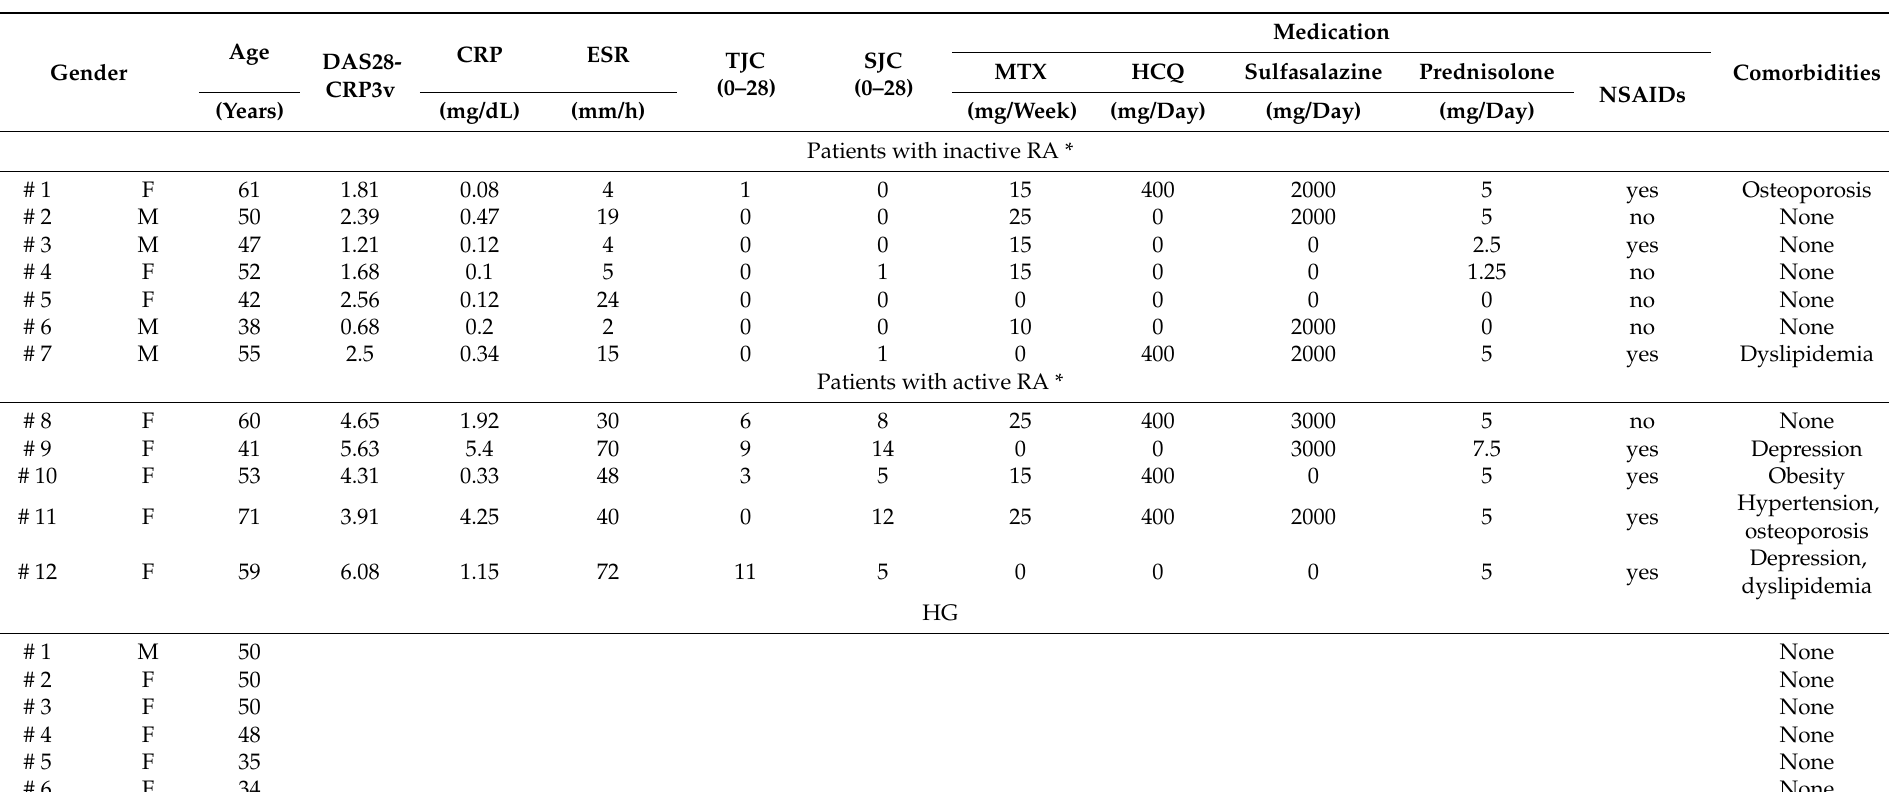
Table A1. Demographic data and clinical characteristics of rheumatoid arthritis patients and healthy